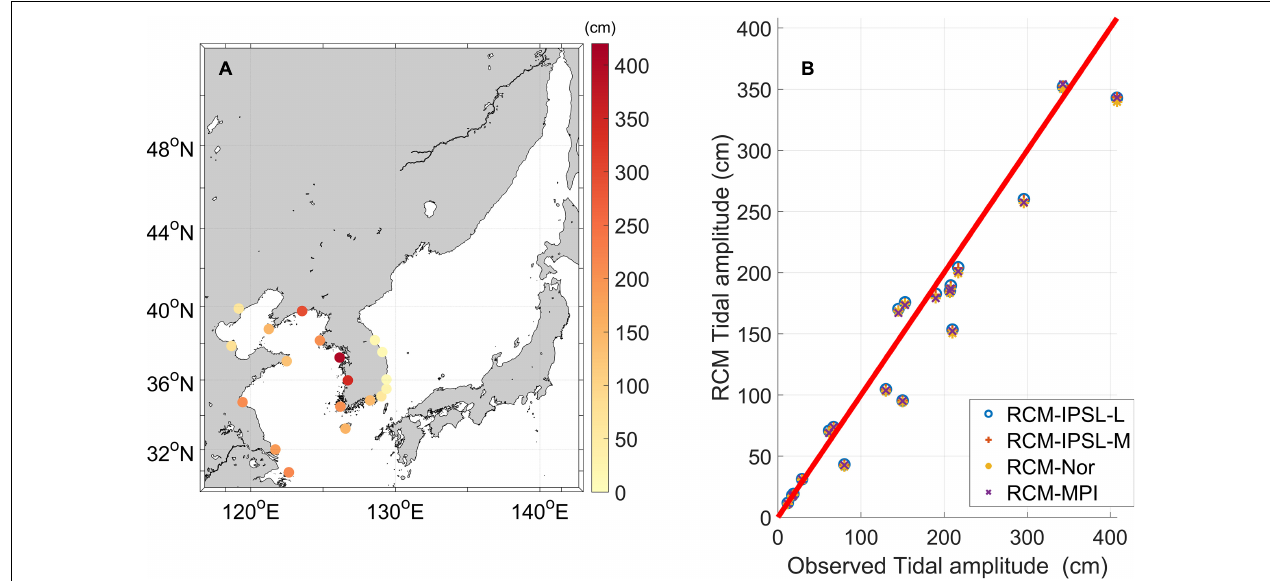
FIGURE 7 | (A) Sum of the amplitudes (unit: cm) for four major tidal constituents ( M 2 , S 2 , K 1 , and O 1 ) at the observation station from Choi (1980). Point colors represent the tidal amplitude at the station. (B) Comparison of observed and 2005 RCM tidal amplitudes.